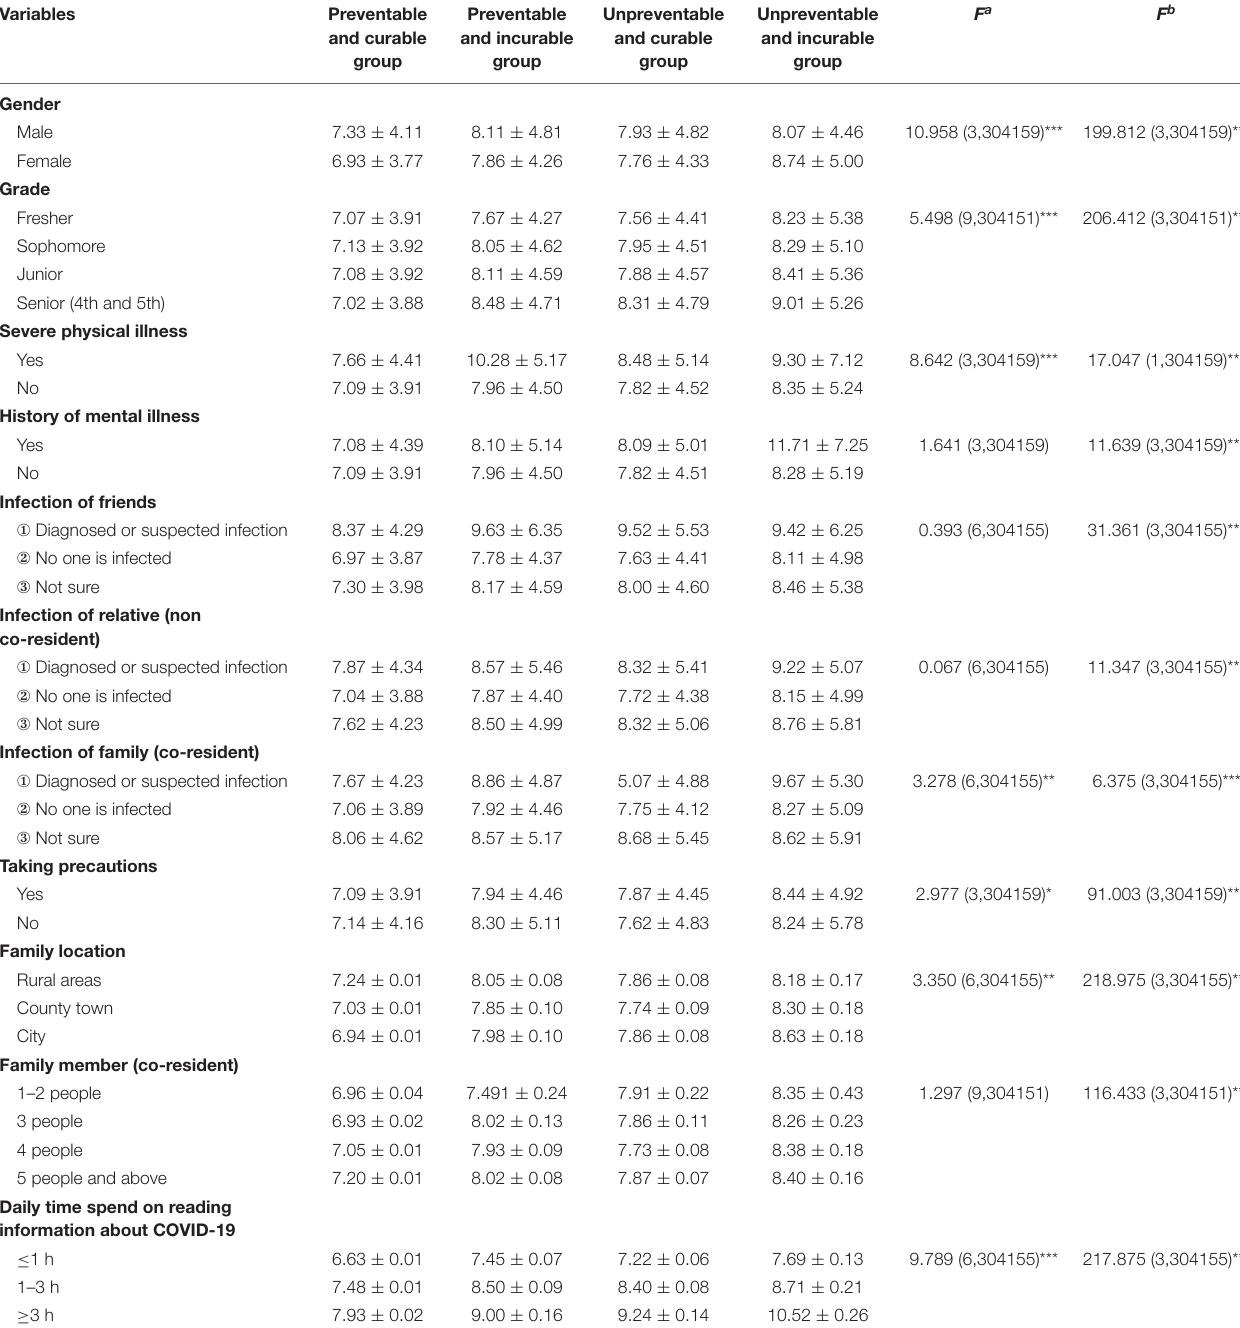
TABLE 3 | Associations between psychological stress symptoms, demographic data, and perceptions of